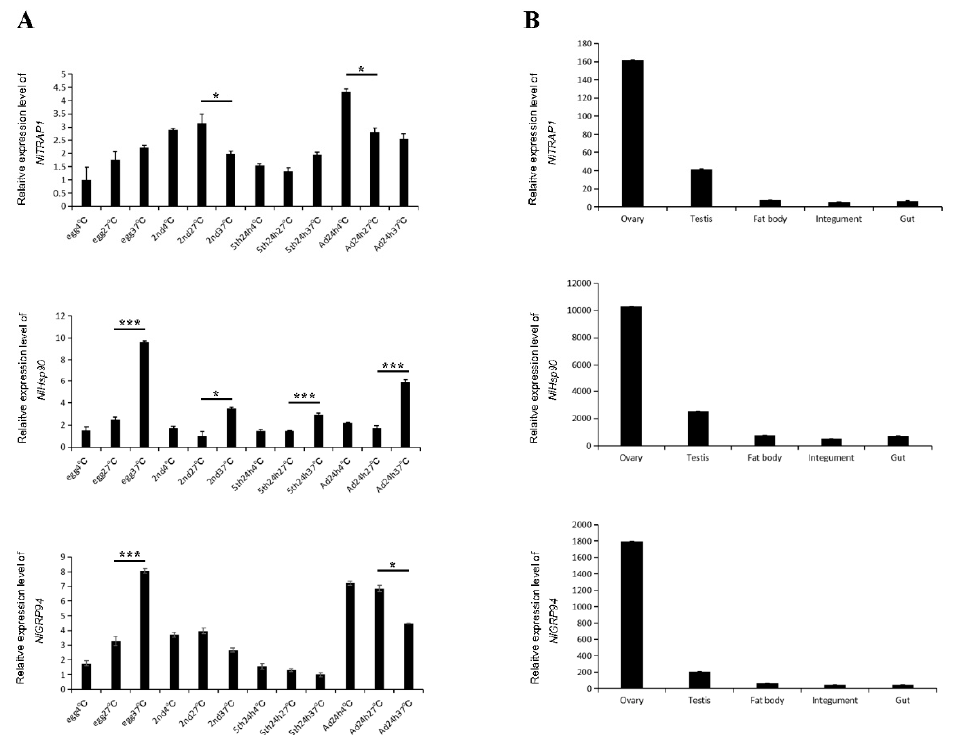
Figure 3. Developmental and tissue-specific expression patterns of NlHsp90 , NlTRP94 and NlTRAP1 . ( A ) Developmental profile of three genes under different temperatures. Total RNA was isolated from eggs, second instar nymphs, fifth instar nymphs and adults 24 h after molting at 4 °C, 27 °C and 37 °C for 1 h. ( B ) Tissue-specific expression of three genes. Total RNA was isolated from ovary, testis, fat body, integument and gut of BPH. Real-time qPCR (RT-qPCR) combined with the 2 − ∆∆ Ct method was used to evaluate the relative expression levels of target genes. The results are presented as the mean ± SEM (standard error of mean). * p < 0.01, *** p < 0.001 (Student’s t -test). Bars represent the SEM derived from three independent biological replicates.